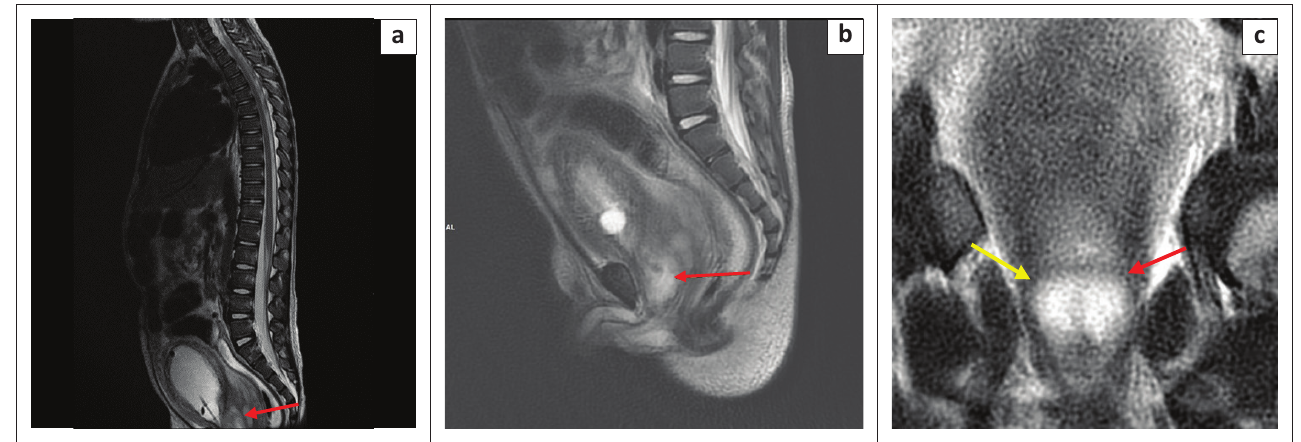
FIGURE 4: Magnetic resonance imaging: Sagittal T2-weighted sequence (a) of the thoracic and lumbar spine. Incidental cyst of the prostate gland was noted. Sagittal and coronal T2-weighted sequences (b and c, respectively) of the pelvis demonstrate a well-defined homogenous cystic lesion within the prostate gland in keeping with a prostatic